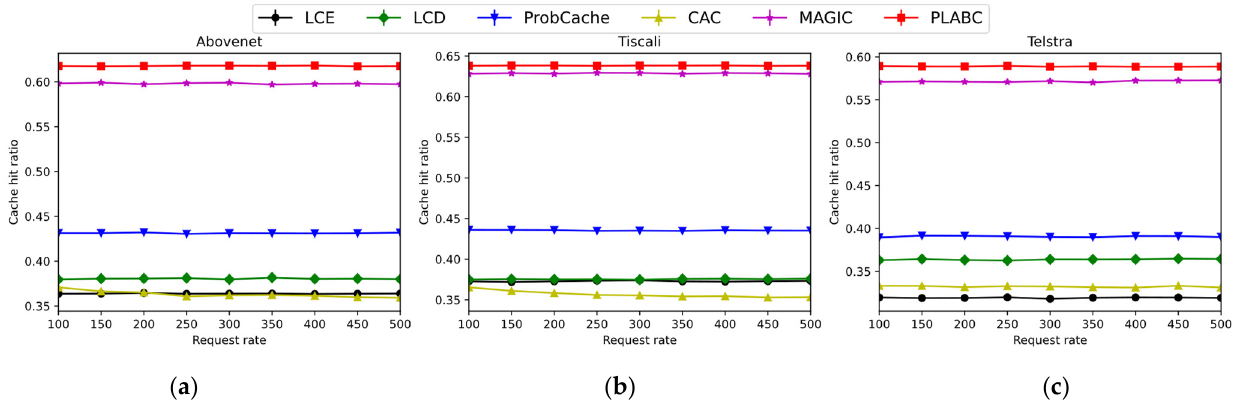
Figure 12. Cache hit ratio results of different caching strategies when the total request rate varies under topology: ( a ) Abovenet; ( b ) Tiscali; ( c ) Telstra.